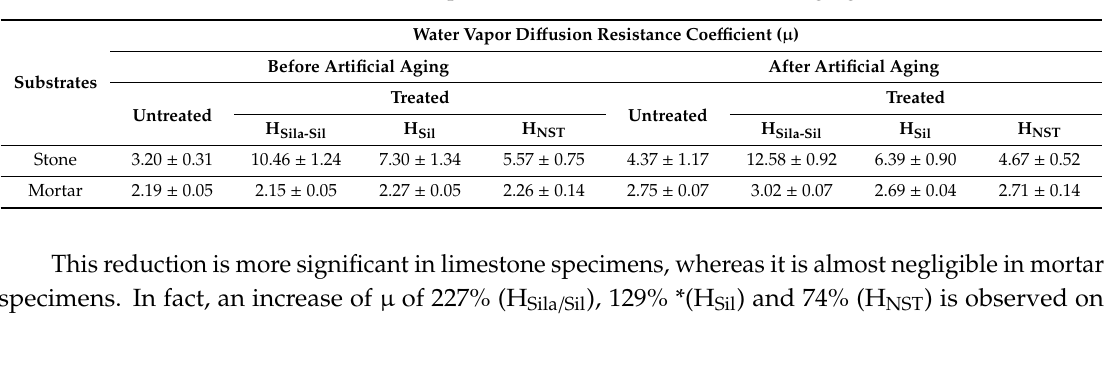
Table 7. Average results and relative standard deviation of the water vapor di ff usion resistance coe ffi cient ( µ ) of treated and untreated specimens, before and after artificial aging tests.